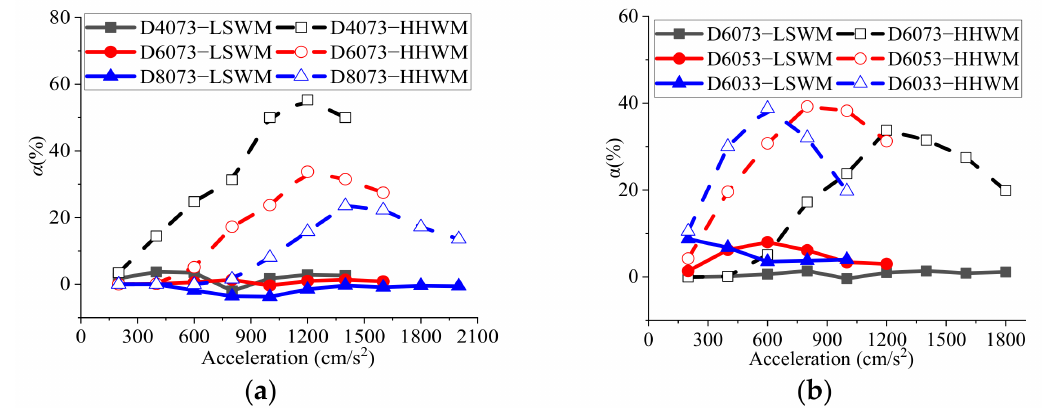
Figure 14. Values of α -1p for shells with different spans and rise-to-span ratios: ( a ) Influence of the span; ( b ) influence of the rise-to-span